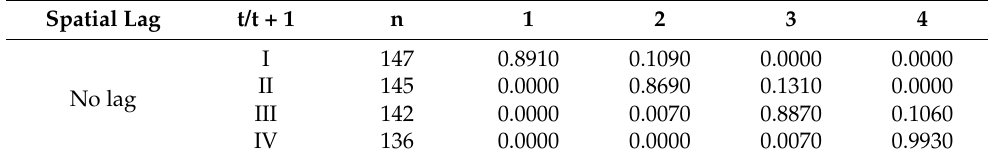
Table 3. Traditional Markov probability transfer matrix of China’s carbon emissions from 2000 to 2020.